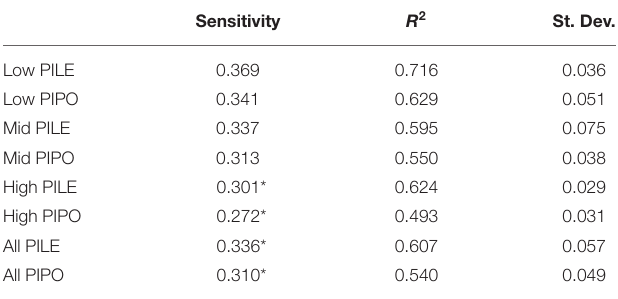
TABLE 2 | Tree-ring chronology statistics for each species and elevation. Sensitivity R 2 St. Dev.